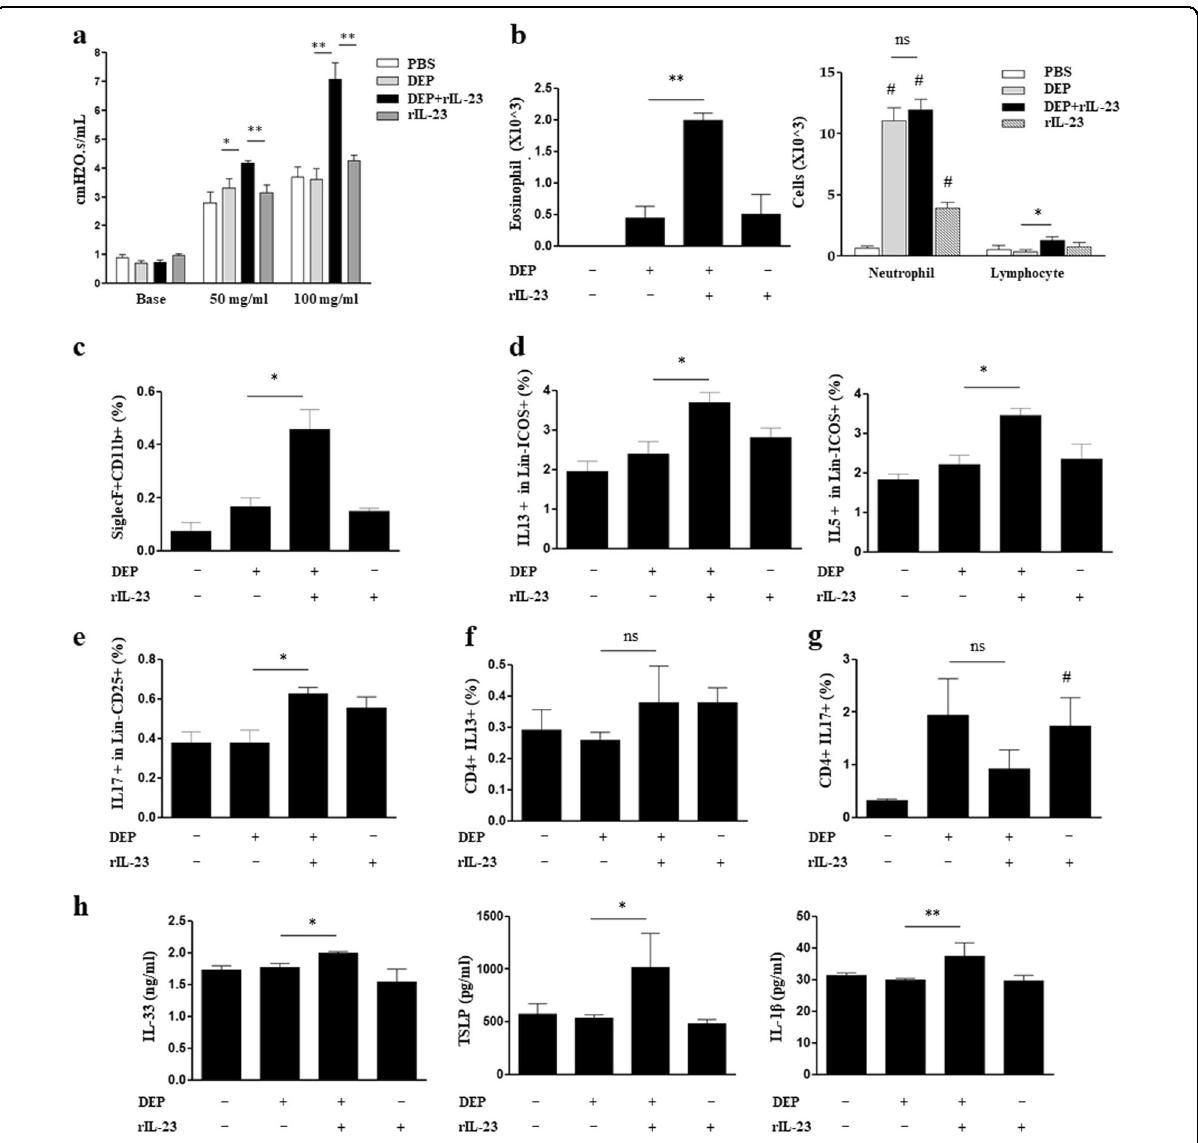
Fig. 3 Nonallergic eosinophilic asthma phenotype of the DEP/rIL-23 model. a Airway resistance at doses of 50 and 100 mg/mL methacholine (MCh). b Eosinophils, neutrophils, and lymphocytes in bronchoalveolar lavage fl uid. c CD11b + siglecF + CD11c − cells in bronchoalveolar lavage fl uid. d IL-13 or IL5-producing type 2 innate lymphoid cells (CD45 + Lin − ICOS + ) in lung homogenate. e IL-17A-producing type 3 innate lymphoid cells (CD45 + Lin − CD25 + ) in lung homogenate. f , g IL-13-producing or IL-17A-producing CD4 + T cells in lung homogenate. h IL-33, TSLP, and IL-1 β levels in lung homogenate. * P < 0.05, ** P < 0.01 between two groups; # P < 0.05 compared to the control group; DEP diesel exhaust particle; ns, not signi fi cant; PBS phosphate-buffered